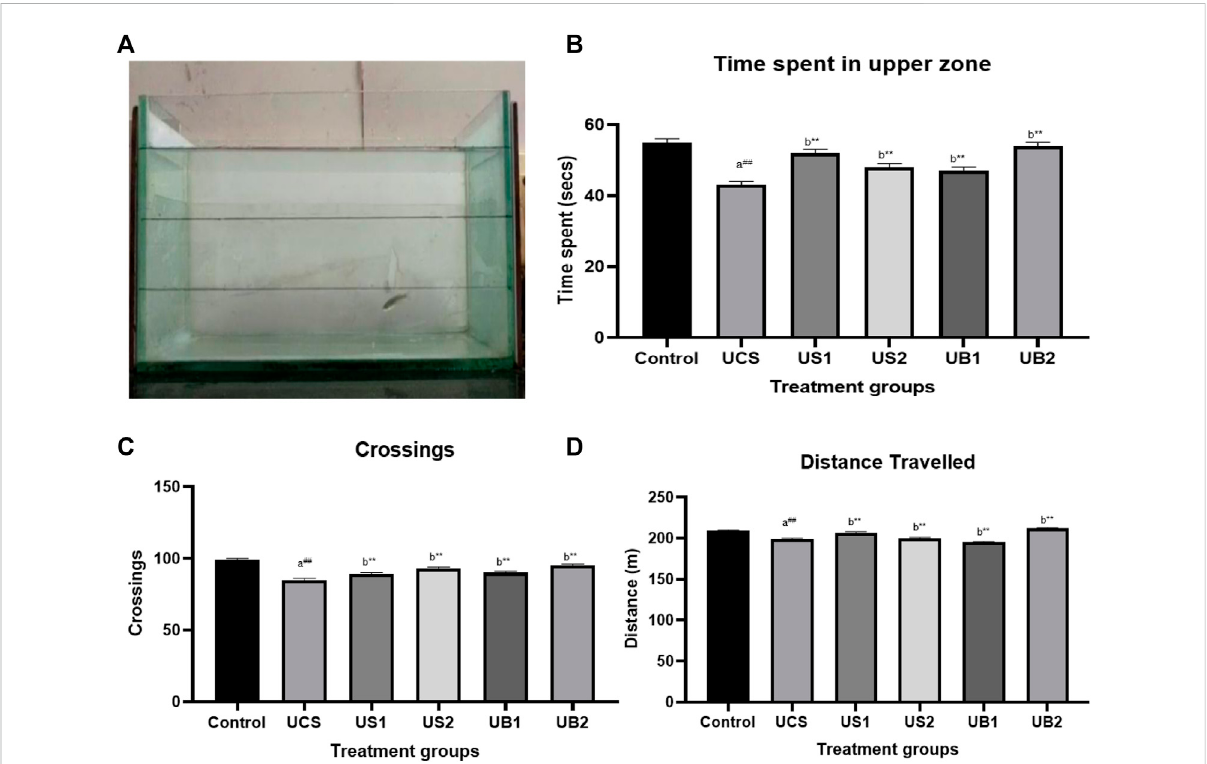
FIGURE 5 (A) Novel tank testof drug-treatedgroup showing the exploratory behaviour of zebra fi sh (UCS) (B) The effect of treatment on time spent in the upper level of the tank in novel tank (UCS) (C) The effect of treatment on crossing of zones in novel tank (UCS) (D) The e ffect of treatment on total distance travelled in novel tank (UCS).Values were expressed as mean ± S.E.M. A one-way ANOVA followed by Bonferroni post hoc test ( n = 8 – 10) wasused. (A) Comparisonsweremadebetweenthestressedgroup(UCS)withnormal control. (B) Comparisonsweremadebetween US1,US2, UB1, and UB2 with stressed group (UCS). p-value ***represents p < 0.001, **represents p < 0.01, *represents p < 0.05, ## represents p < 0.01. (B) shows the in fl uence of baicalein, diazepam and fl uoxetine on behavioral parameters in zebra fi sh subjected to UCS. As expected, UCS increased the time spent in thebottom area and decreased theentries as well as thetime inthe top area. The control group (control) showed the time spent inthe upperzone(55 s)andthestressedgroup(UCS)showeddecreasedinthetimespentintheupperzone(42 s).Baicalein-treatedgroups(UB1andUB2) were found to explore more in the upper levels of the tank following transfer to a novel tank in comparison to standard drugs. On the other hand, UB1 group has increased time spent (47 s) while the UB2 group had 54 s as the time spent [panel (B) ]. Fluoxetine and diazepam-treated